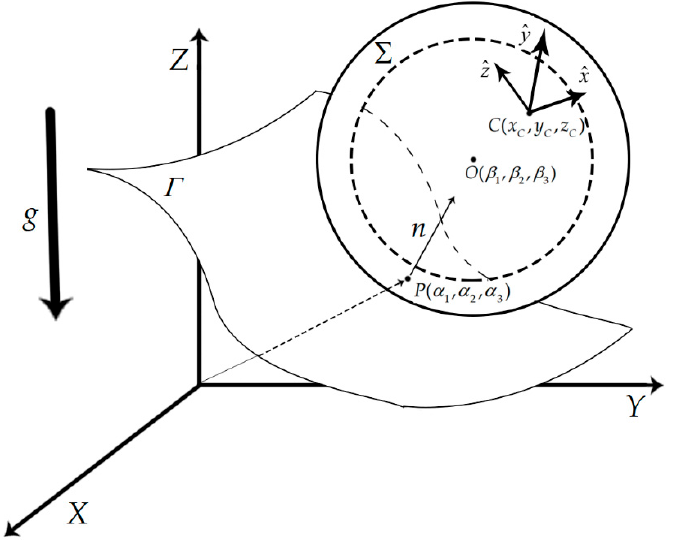
Figure 2. The constrained system consisting of the shell Σ in contact with the surface Γ , a zero-mass particle P located at the contact point, and a zero-mass particle O located at the center of the shell. The unit normal vector perpendicular to the surface Γ at P is n .